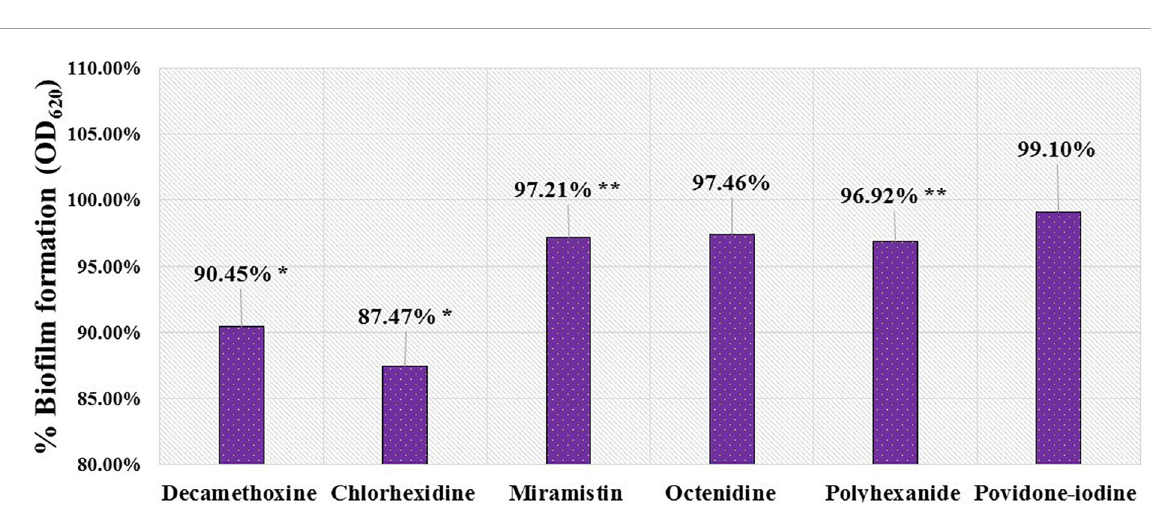
FIGURE2 Percentage indicator of the biofilm-forming ability of A.baumannii ( n = 42) in the presence of sub-inhibitory concentrations of antiseptics compared to the untreated control. *- coefficient of reliability ( p < 0.001); **- coefficient of reliability p <